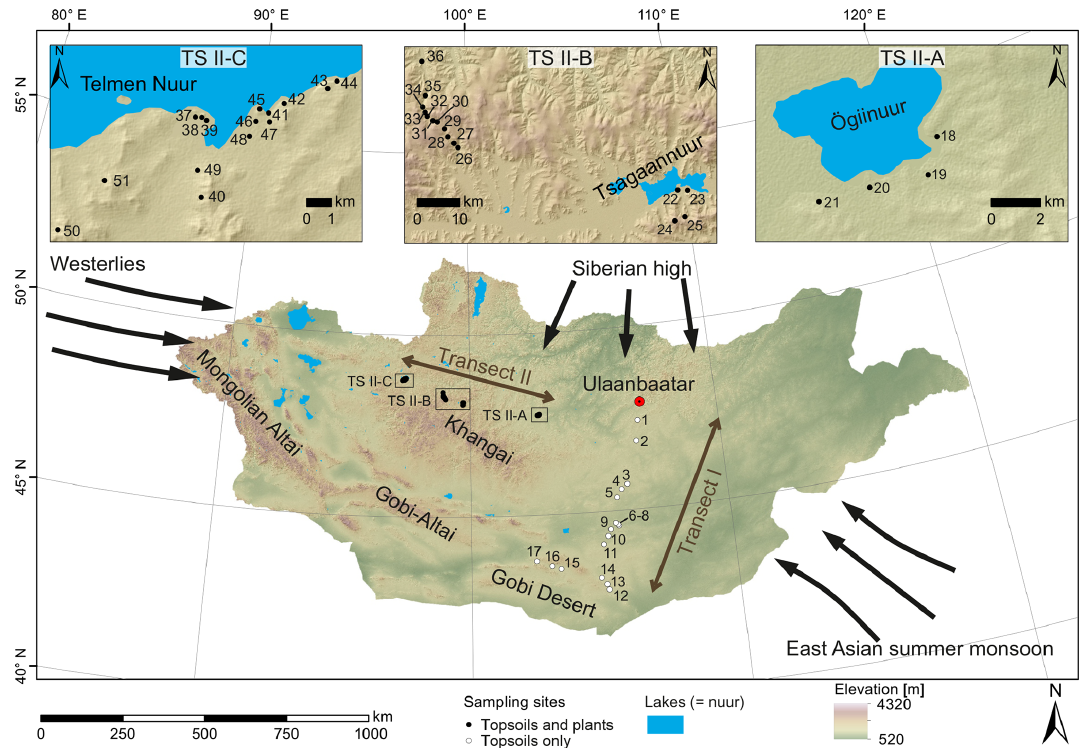
Figure 1. Map of Mongolia (SRTM digital elevation model). The black and white circles mark the sampling sites along transect I and II. Black arrows indicate the influence of three major atmospheric circulation systems: the Westerlies, the East Asian summer monsoon and the Siberian high. Submaps show (TS II-A) the Ögiinuur catchment, (TS II-B) an altitude transect near the Tsagaannuur catchment and (TS II-C) the Telmen Nuur catchment in more detail.